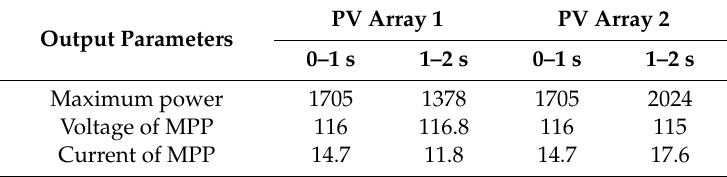
Table 2. The output parameters of the PV arrays at maximum power point under condition 1.